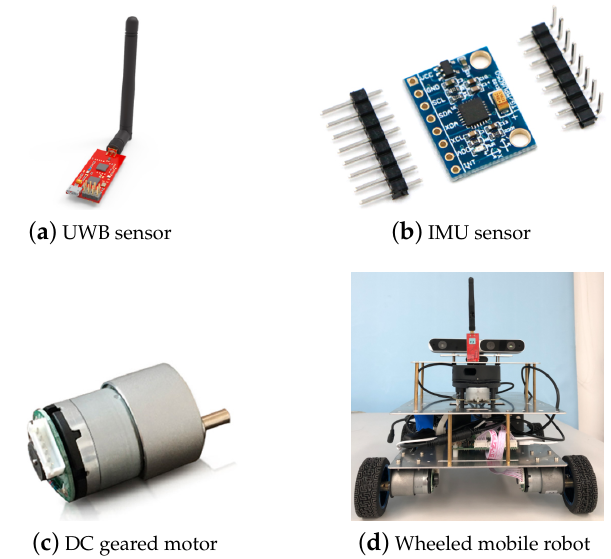
Figure 3. The sensors and mobile robot involved in this